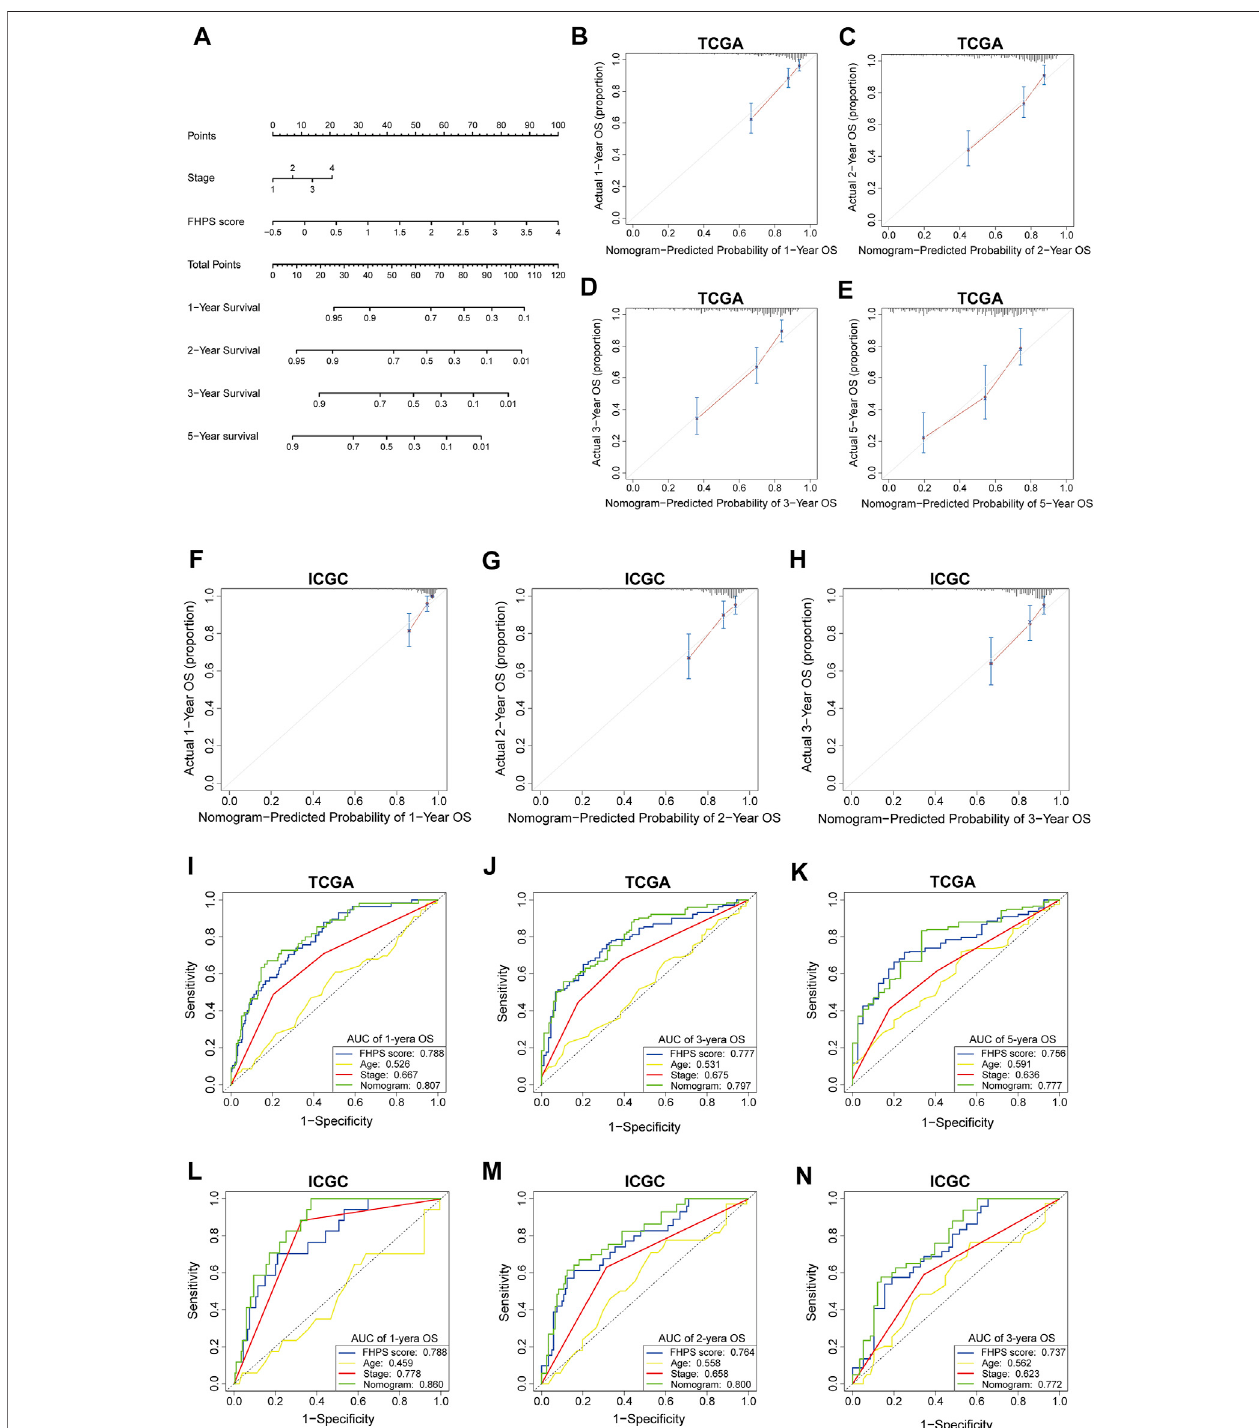
FIGURE 9 | (A) Nomogram based on FHPS score, and TNM stage. (B-E) Calibration plots of the nomogram for predicting the probability of OS at 1, 2, 3, and 5 yearsintheTCGAcohort. (F-H) CalibrationplotsofthenomogramforpredictingtheprobabilityofOSat1,2,and3 yearsintheICGCcohort. (I – K) ROCcurvesforthe nomogram,FHPSscore,age,andTNMstageintheTCGAcohort(forpredicting1,3,and5-yearsOS). (L – N) ROCcurvesforthenomogram,FHPSscore,age,andTNM stage in the ICGC cohort (for predicting 1, 2, and 3-years OS).